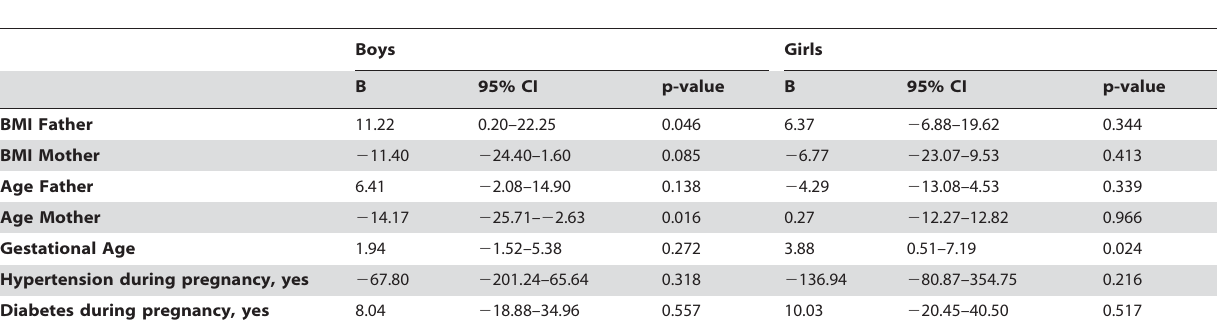
Table 5. Multivariable regression analysis of factors predicting fetal cortisol in male and female new-born.